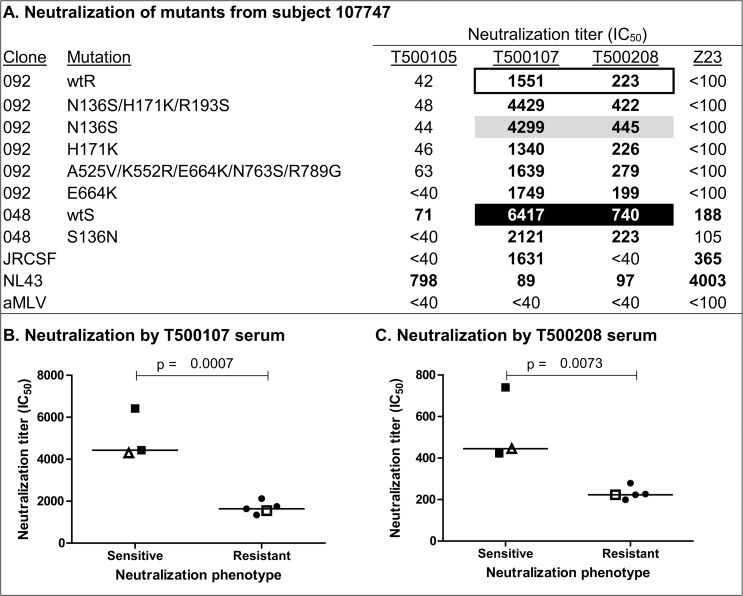
Mutational analysis to map residues responsible for differences in sensitivity and resistance in Envs from subject 107747.Amino acids from the neutralization-sensitive clone (048) were systematically inserted into the neutralization-resistant Env (092). (A) Effect of sequence polymorphisms on neutralization by plasma from four HIV-1 infected subjects. The neutralizing antibody titer (IC50) is defined as the reciprocal of the plasma dilution that produces a 50% inhibition in target cell infection. Values in bold represent significant neutralization titers that are at least three times greater than those observed against the negative control (aMLV). Panel A, open rectangle, indicates neutralization titers for the wildtype resistant (wtR) clone; black rectangle, indicates neutralization titers for the wildtype sensitive (wtS) clone; gray rectangle, indicates the single amino acid substitution that converted the neutralization-resistant Env into a neutralization-sensitive Env. Panels B and C represent graphs and statistical analysis of neutralization-sensitive and -resistant viruses with the T500107 and T500208 plasma, respectively. Panels B and C, closed square (■) indicates neutralization titers of wtS clone 048; open square (□) indicates neutralization titer of wtR clone 092. Open triangles (△) indicate neutralization titers of wtR clone 092 incorporating the N136S mutation. Closed circles (●) indicate neutralization by the other mutants listed in panel A. Statistical significance was calculated using an unpaired t test (GraphPad Prism).